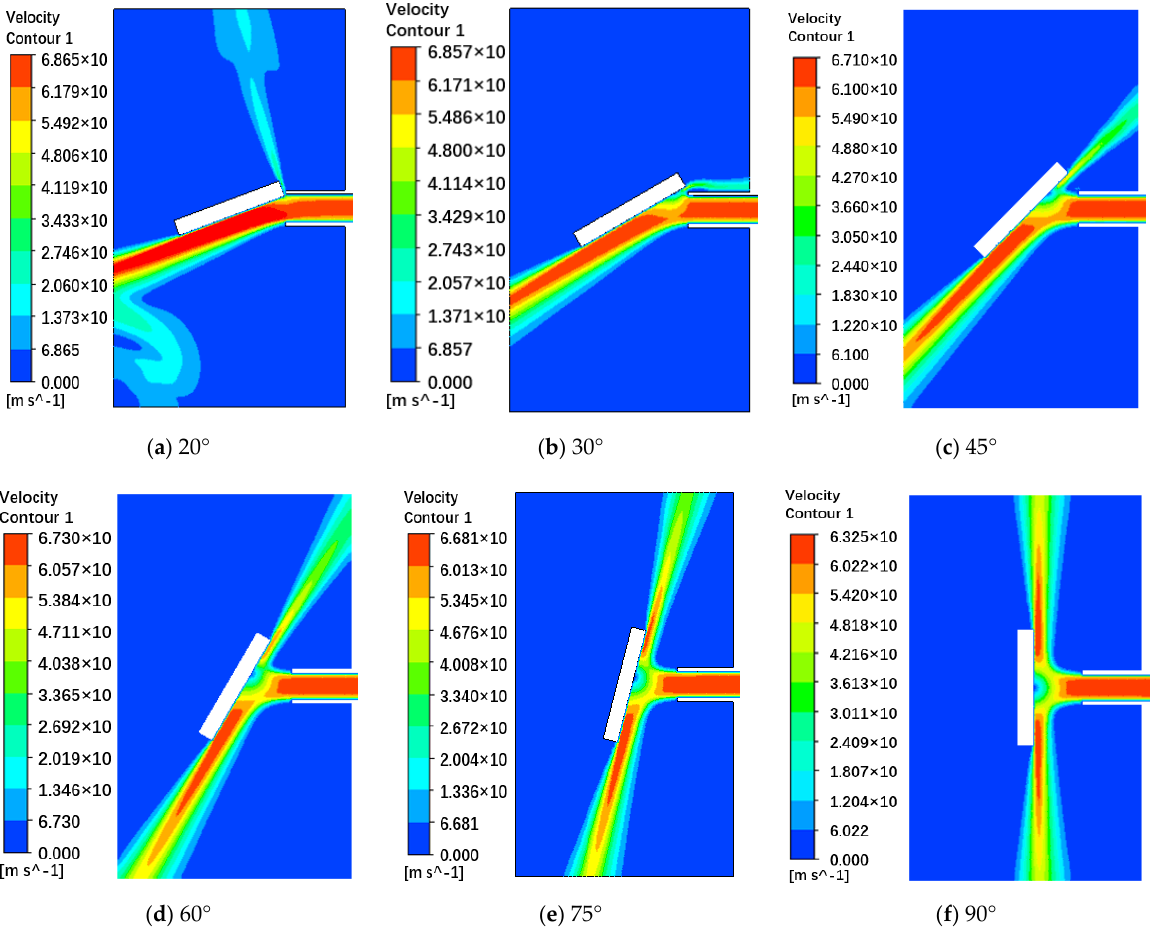
Figure 9. A comparison of the velocity nephogram results at different impact angles ( v g = 60 m/s, v p = 19 m/s, and d p = 300 μm). ( a ) 20° impact velocity nephogram. ( b ) 30° impact velocity nephogram. ( c ) 45° impact velocity nephogram. ( d ) 60° impact velocity nephogram. ( e ) 75° impact velocity nephogram. ( f ) 90° impact velocity nephogram.